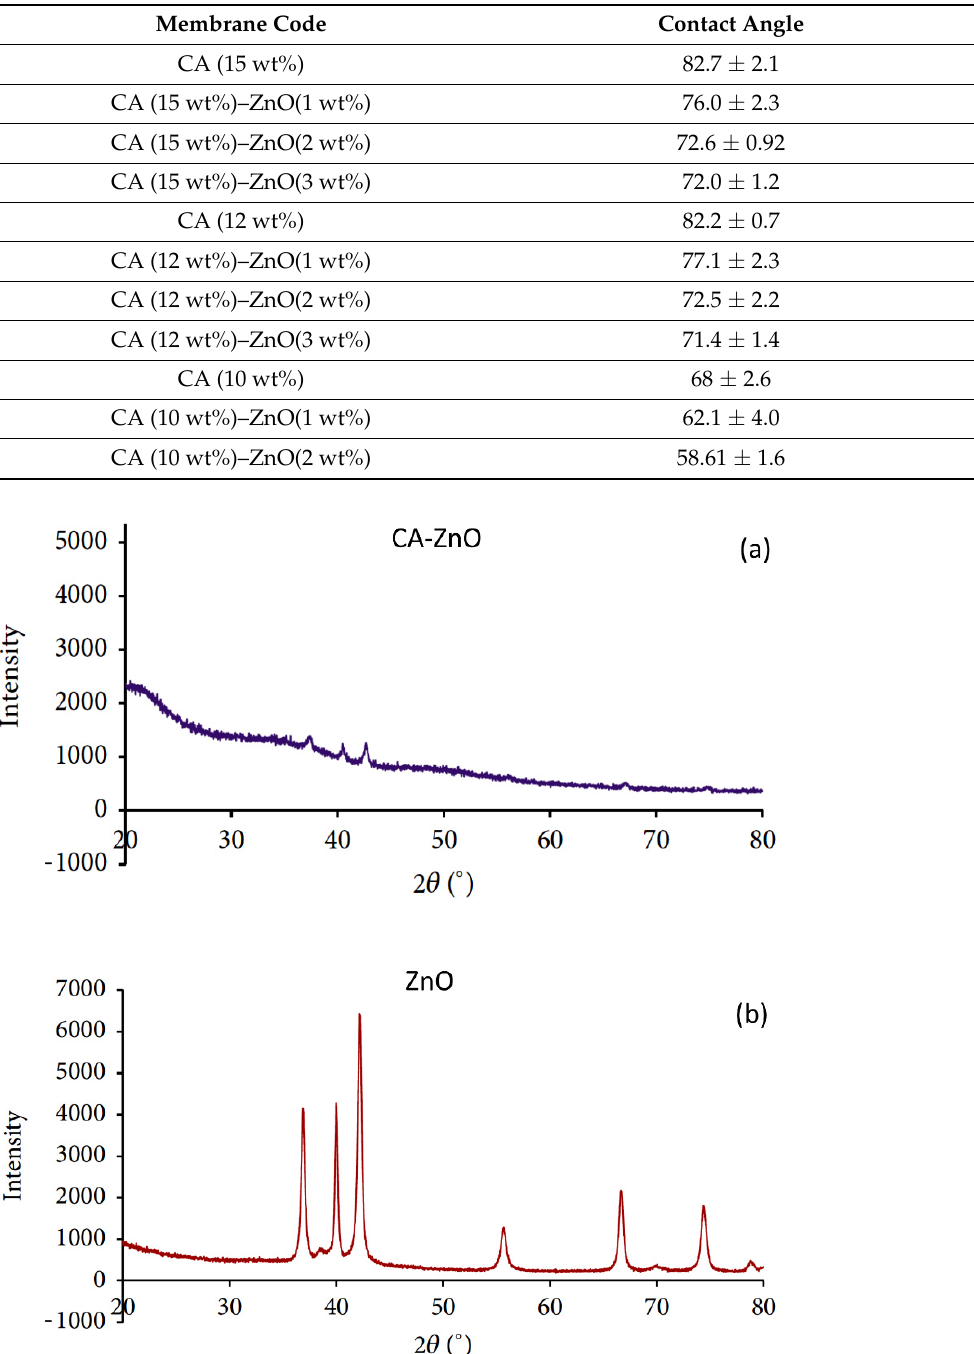
Figure 7. XRD patterns of ( a ) CA- ZnO membrane and ( b ) ZnO nanoparticles.